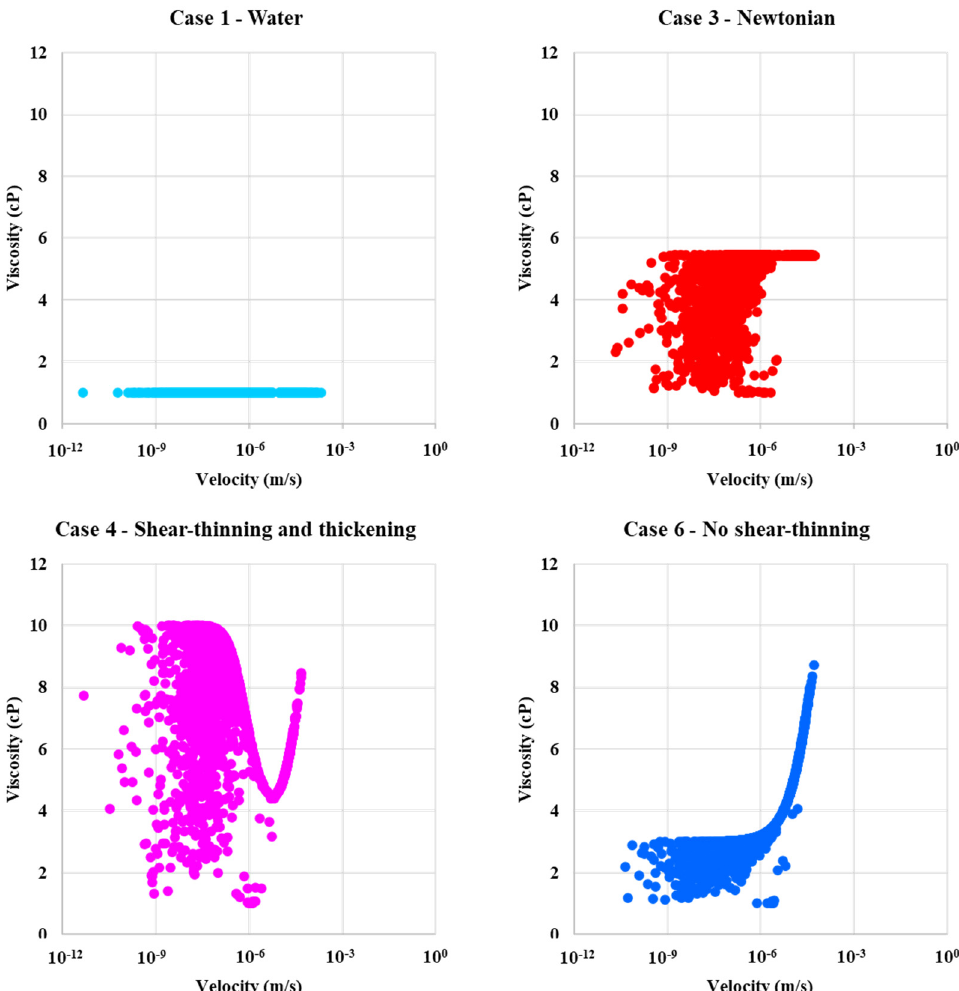
Figure 18. In-situ viscosity as a function of velocity for Case 1—water, Case 3—Newtonian, Case 4—shear-thinning, and Case 6—thickening and no shear-thinning.